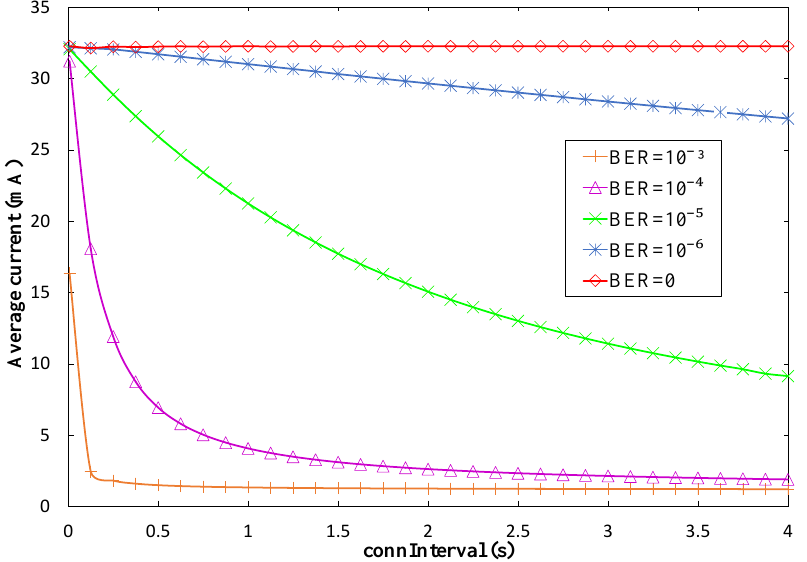
Figure 11. Average current consumption of the sensor node within connInterval (Iavg_CI) in the connection-based approach, as a function of connInterval , and for several BER values.